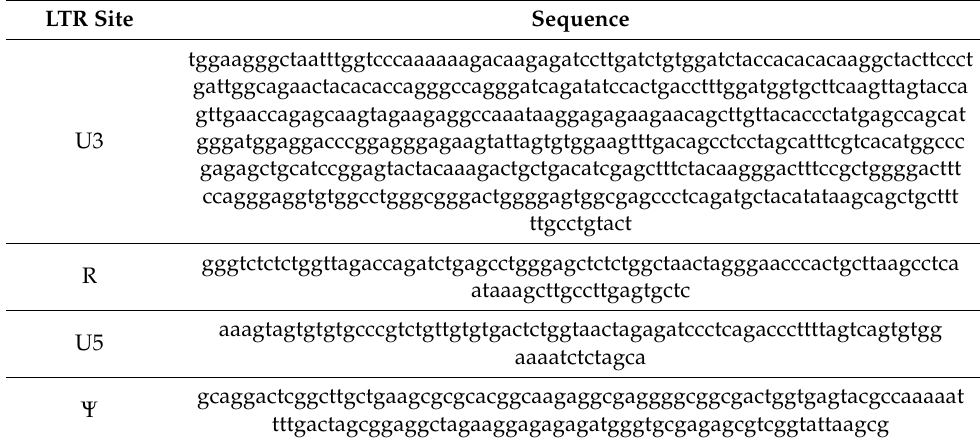
Table 1. The LTR promoter sequences of reporter